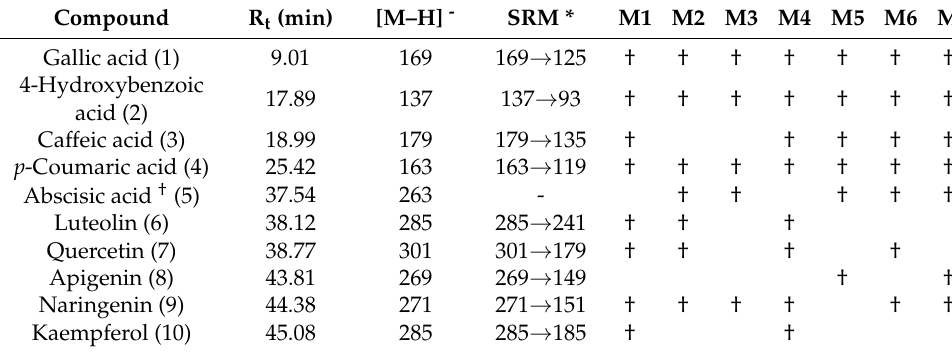
Table 6. List of compounds identified in each honey sample, using LC/MS